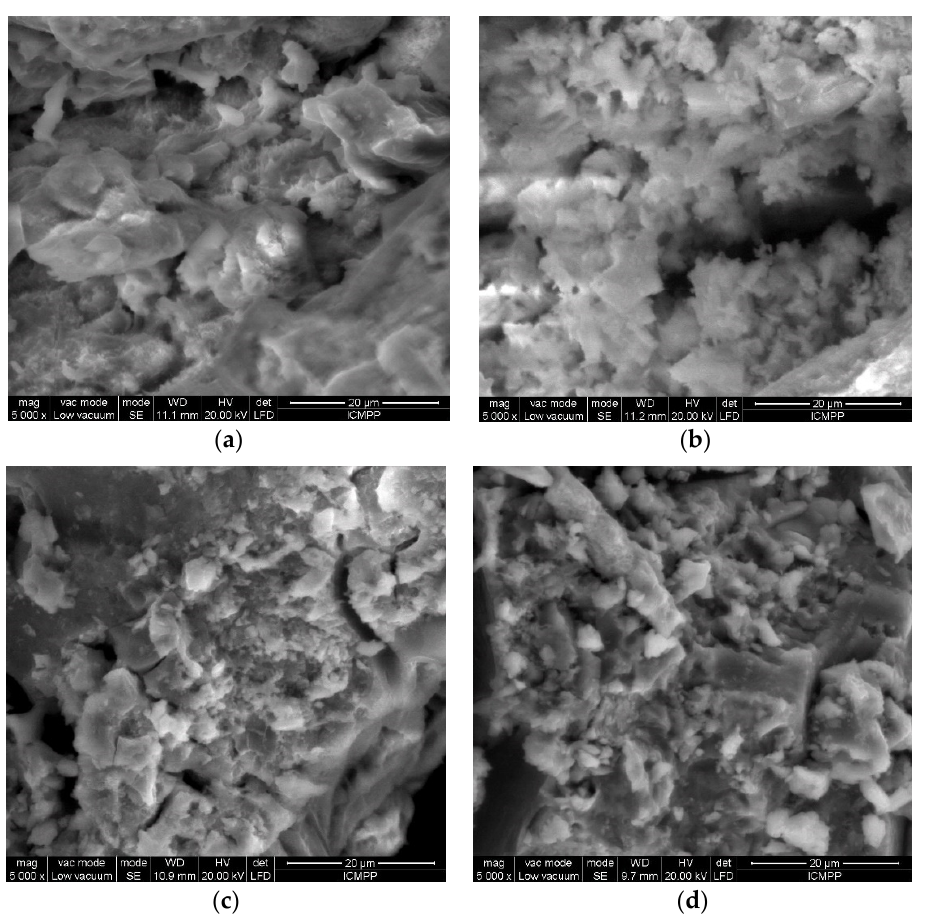
Figure 6. SEM images of alginate before ( a ) and after ( b ) Cu(II), ( c ) Co(II) and ( d ) Zn(II) ion biosorption. After Cu(II) ion biosorption (Figure 6b), the morphology of biosorbent surface seems to be changed, becoming even more heterogeneous and irregular, which indicates that the di ff usion of metal ions from the bulk solution and then their binding to the alginate surface was successfully carried